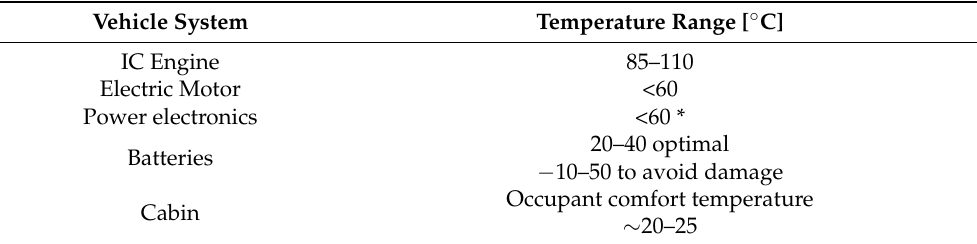
Table 1. Indicative working temperature ranges of the most common vehicle